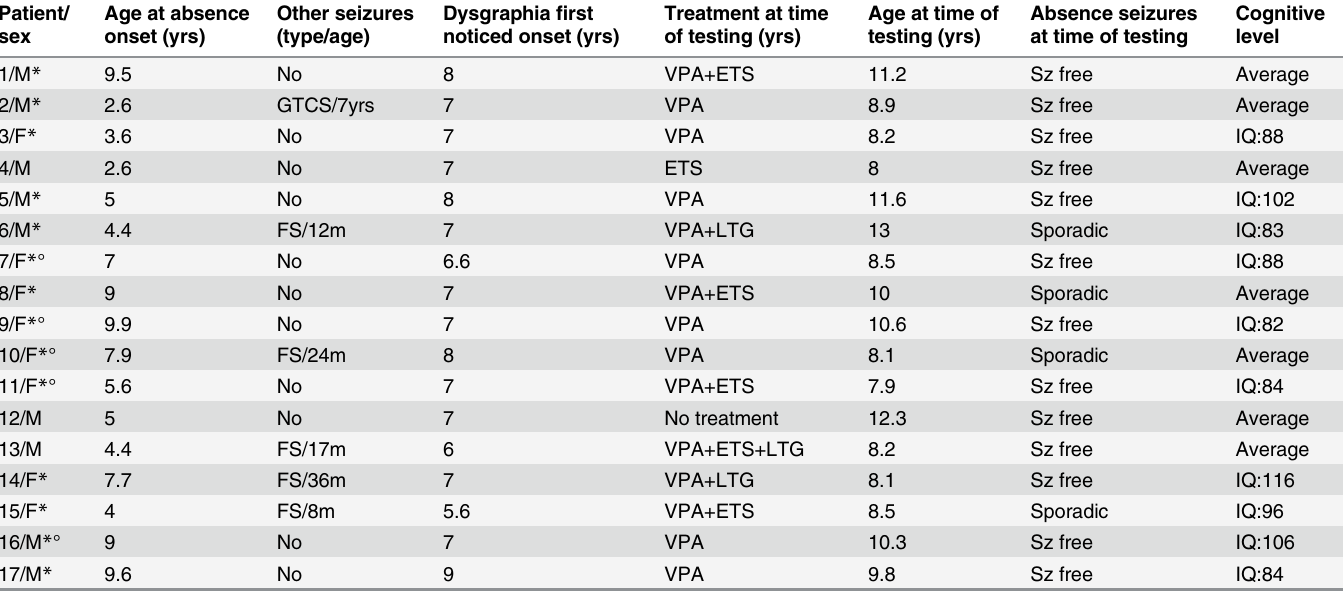
Table 1. Summary of clinical features in 17 children with absence